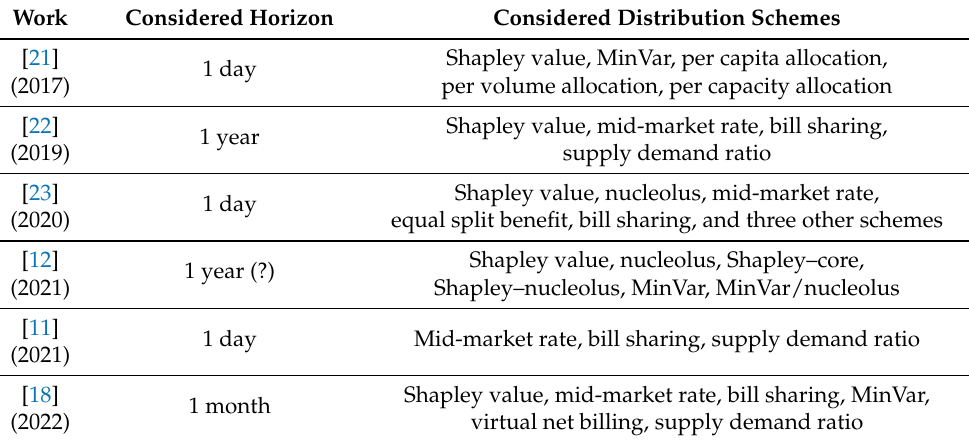
Table 1. Overview of existing works comparing benefit distribution schemes for local energy